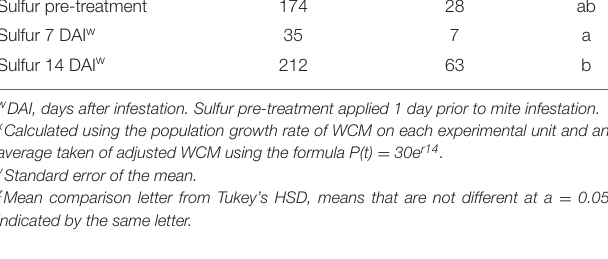
TABLE 7 | Wheat streak mosaic virus presence and grain yield for spring wheat and winter wheat field plots. Active ingredient/s